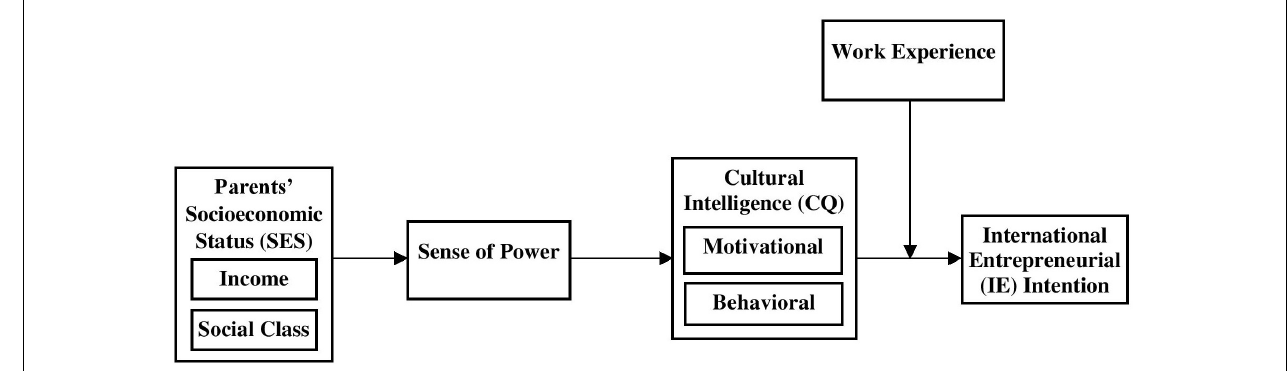
FIGURE 1 | The conceptual